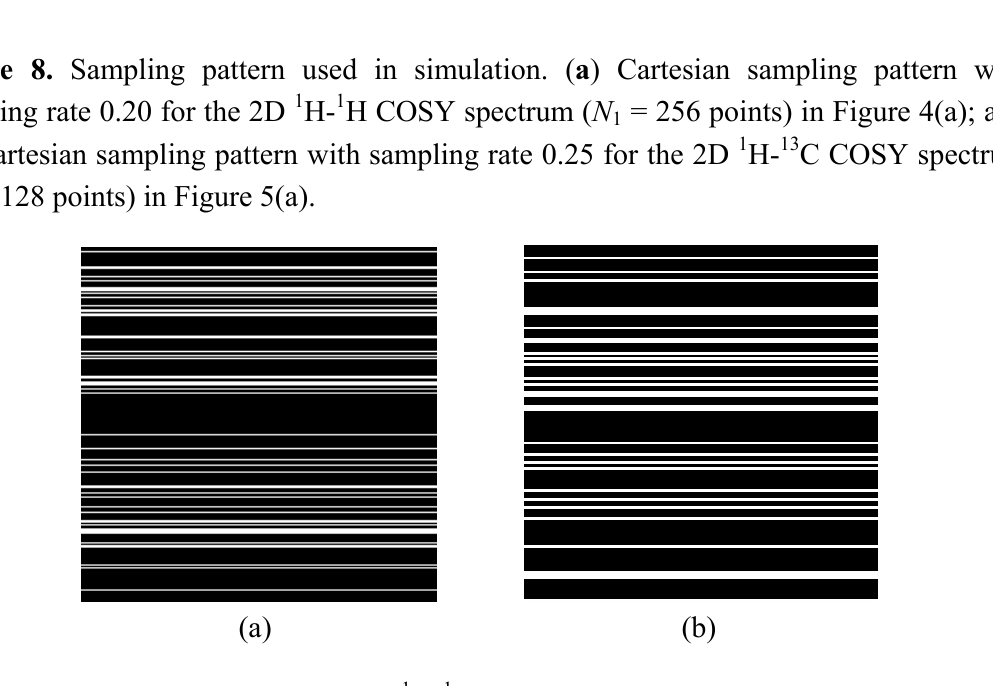
= 256 points) in Figure 4(a); and 1